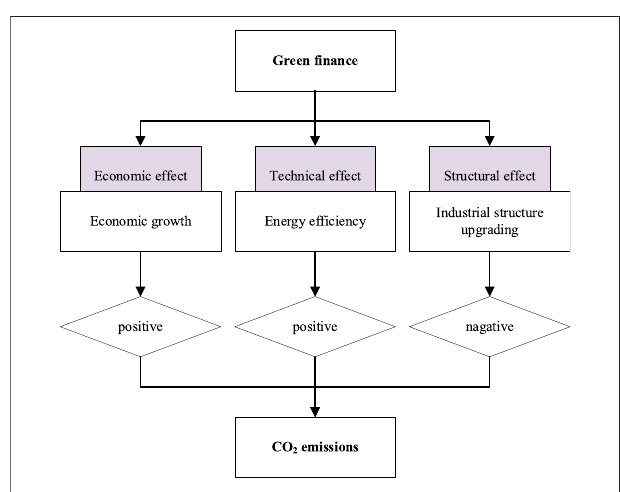
FIGURE 5 | The impact mechanism between green fi nance and CO 2